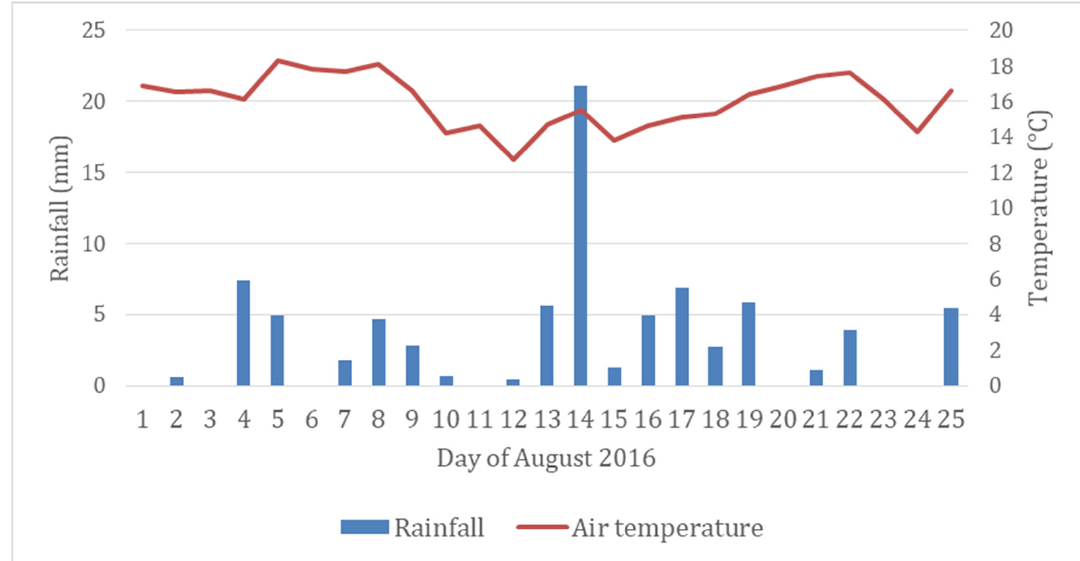
Figure 2. Daily rainfall and mean air temperature at the Kirkkonummi field site during August. The measurements were carried out between 24 and 25 August 2016.